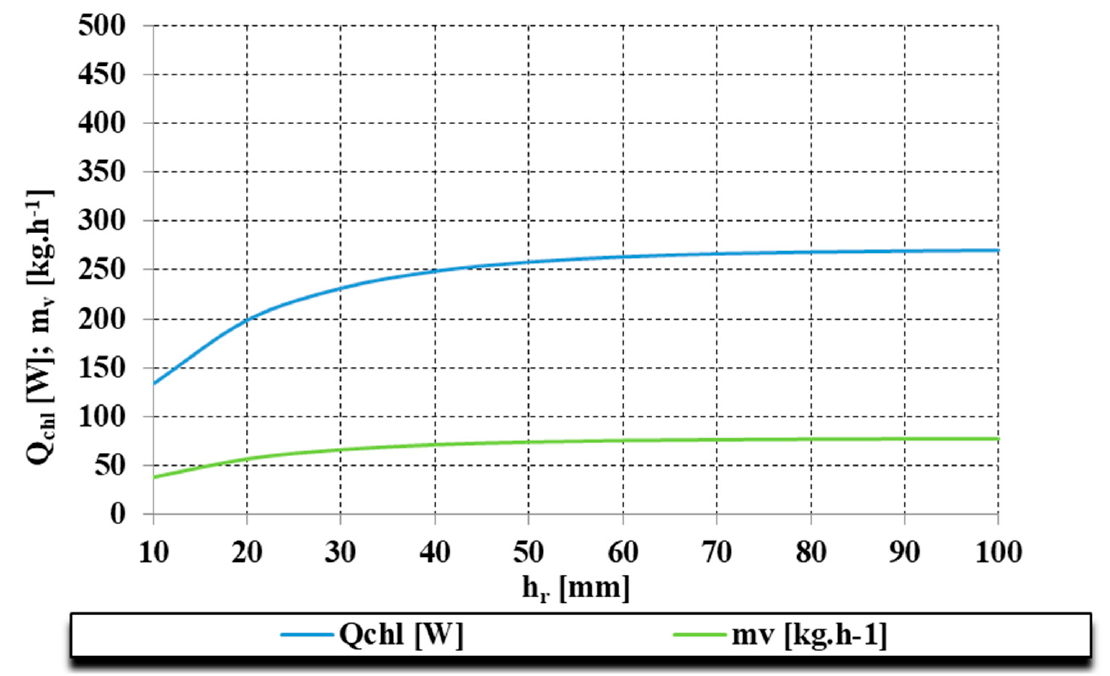
Figure 3. Simulation results when changing the height of the ribs, hr.